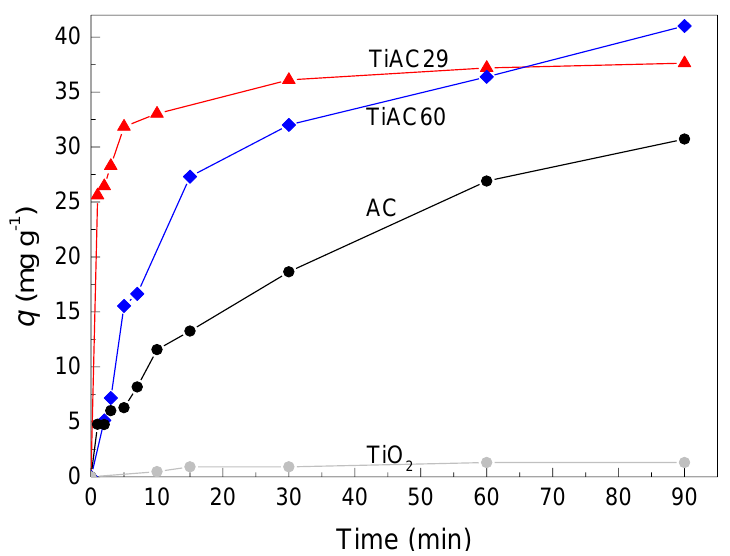
Figure 9. Effect of contact time on MB dye adsorption in the dark for bare materials and composites (dosage = 0.5 g dm −3 , V = 0.02 dm 3 , [MB] = 25 mg dm −3 ).